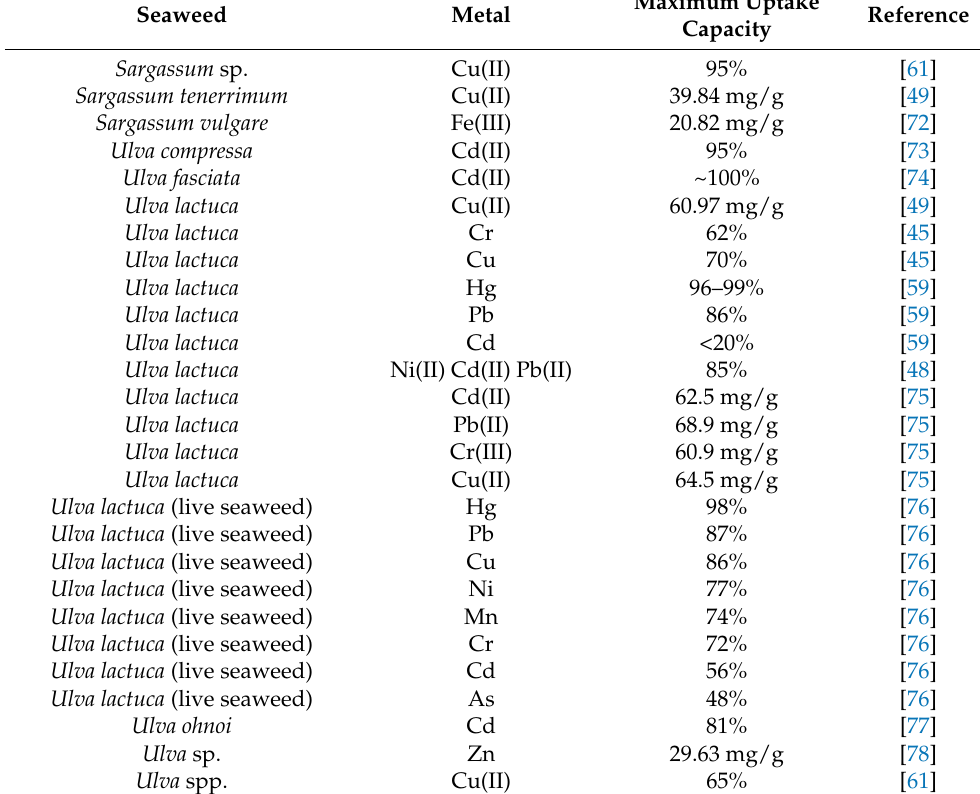
Table 3. Cont. Seaweed